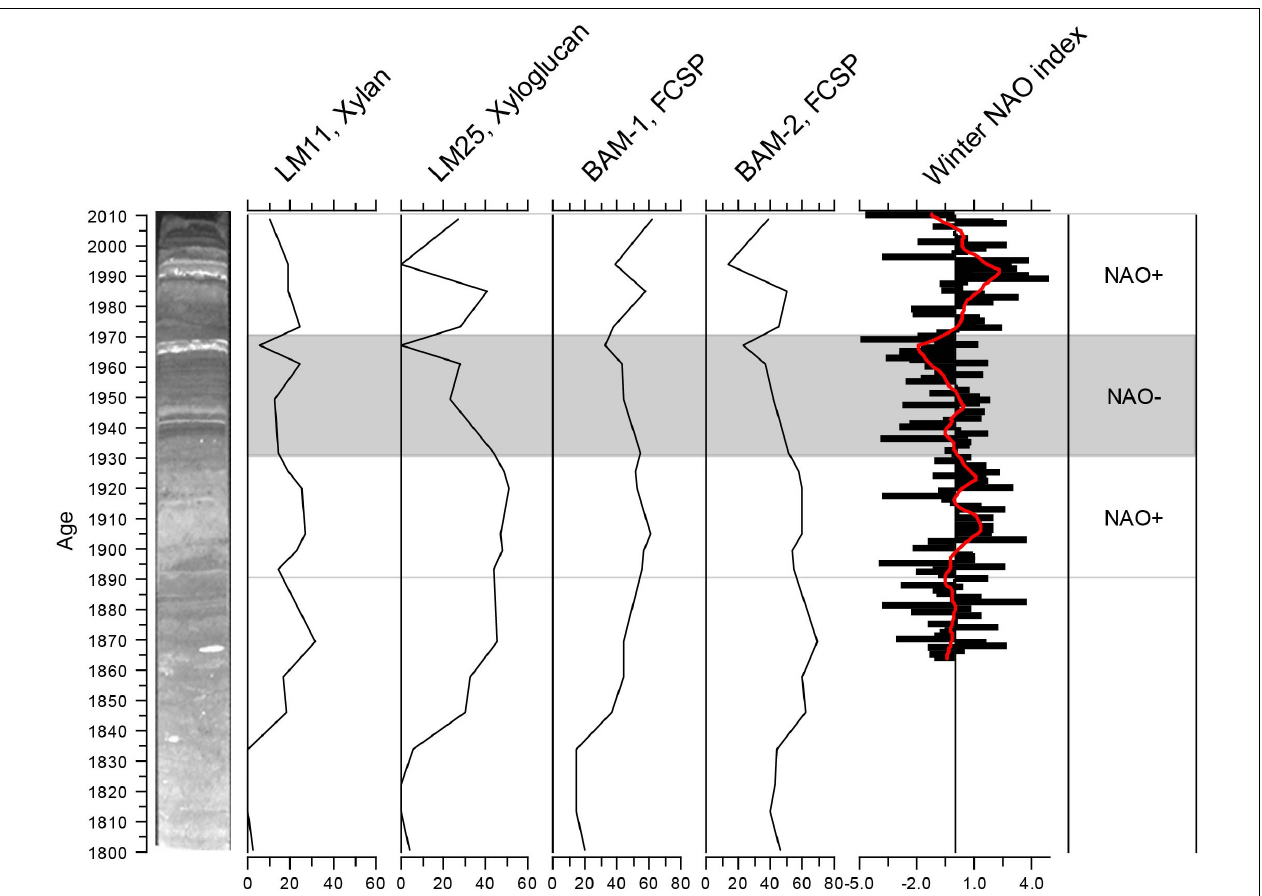
FIGURE 4 | Fluctuations in the four epitopes from Figure 3A , compared with fluctuations in the winter North Atlantic Oscillation (NAO) index (refer to details in